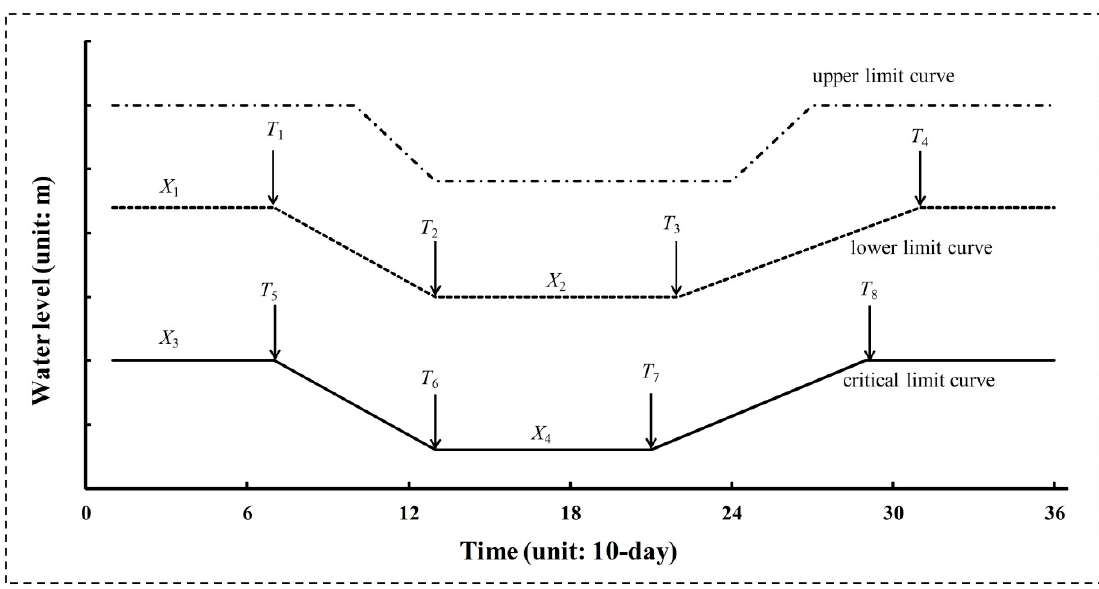
Figure 1. Typical reservoir operating rule curves.